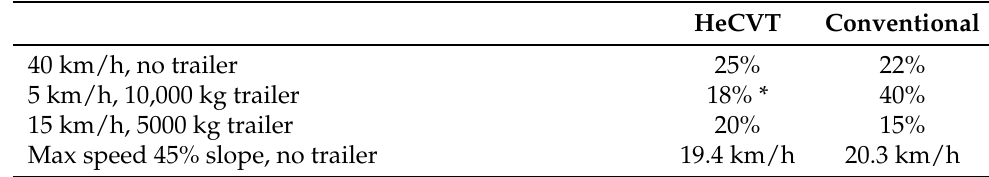
Table 6. HeCVT performance in different slope tests. * Boost function activation required. HeCVT Conventional 40 km/h, no trailer 25% 22% 5 km/h, 10,000 kg trailer 18% * 40% 15 km/h, 5000 kg trailer 20% Max speed 45% slope, no trailer